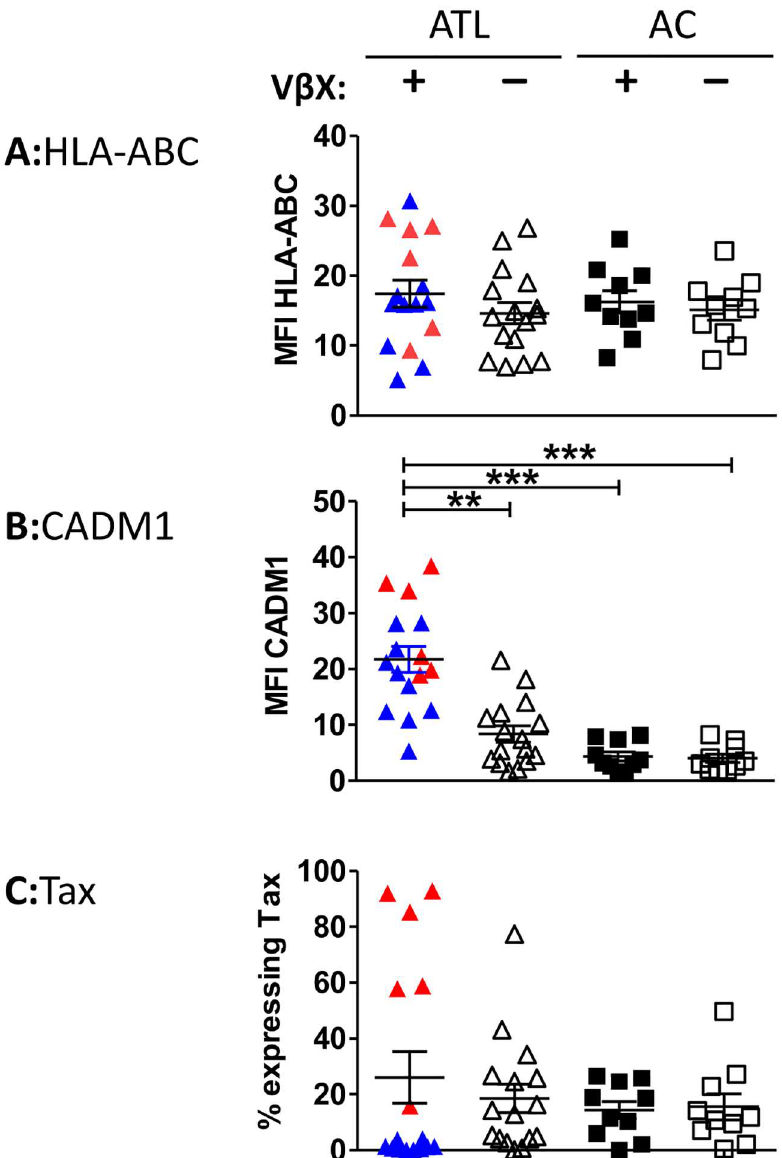
Fig 4. Expression HLA-ABC, CADM1 and Tax by CADM1 + CD4 + T cells. CD8 + cells were depletedfrom PBMCs of 15 ATL patients with a dominant ATL clone detectableby TCRV β staining,and 10 ACs. Cells were culturedfor 18h, after which they were surface stained with a viabilitystain followedby antibodies specific for the most frequently utilised TCRV β (V β X), CD3, CD4, CD8, CADM1, PD-L1, FoxP3 and HLA-ABC (S2 table; panels3, 4, 6 and 7). Cells were then permeabilisedand stainedwith antibodiesspecific for Tax and FoxP3 and analysedby flow cytometry. Cells from ATL patients and ACs were gated on live CD3 + CD4 + CADM1 + cells which were positive or negativefor the dominant TCRV β Xas indicated. Intensity of expressionof (A) MHC class 1 and (B) CADM1. (C) Frequency of Tax expressionby ATL clones. Tax high ATL clones are plotted in red, and Tax low ATL clones are plotted in blue. Statistical analysis: Kruskal-Wallis test with Dunn post-test, 95% CI. * denotesp < 0.05, ** denotesp < 0.01, *** denotesp < 0.001.